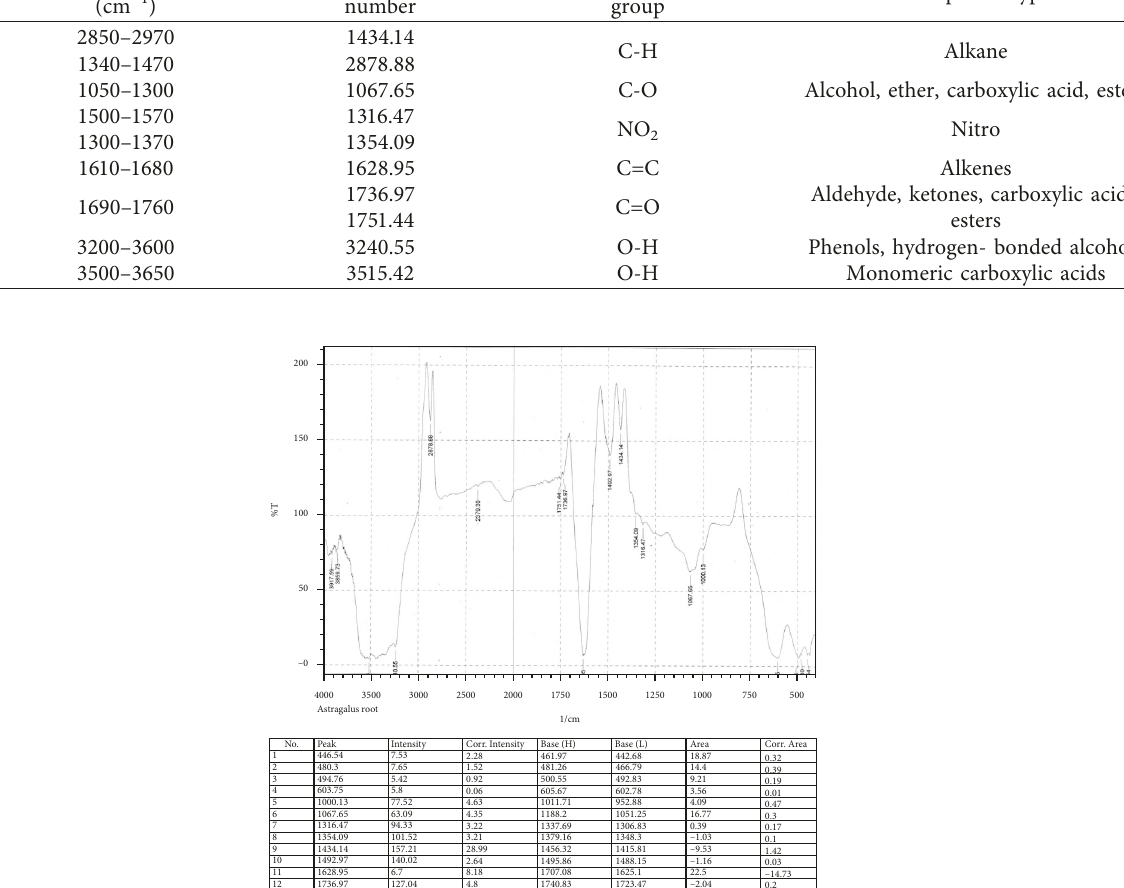
Figure 1: Representative image of the antibacterial effect of A. candolleanus extract against some tested bacterial strains. Table 3: FTIR analysis of hydro-methanolic A. candolleanus root extract. S. no.